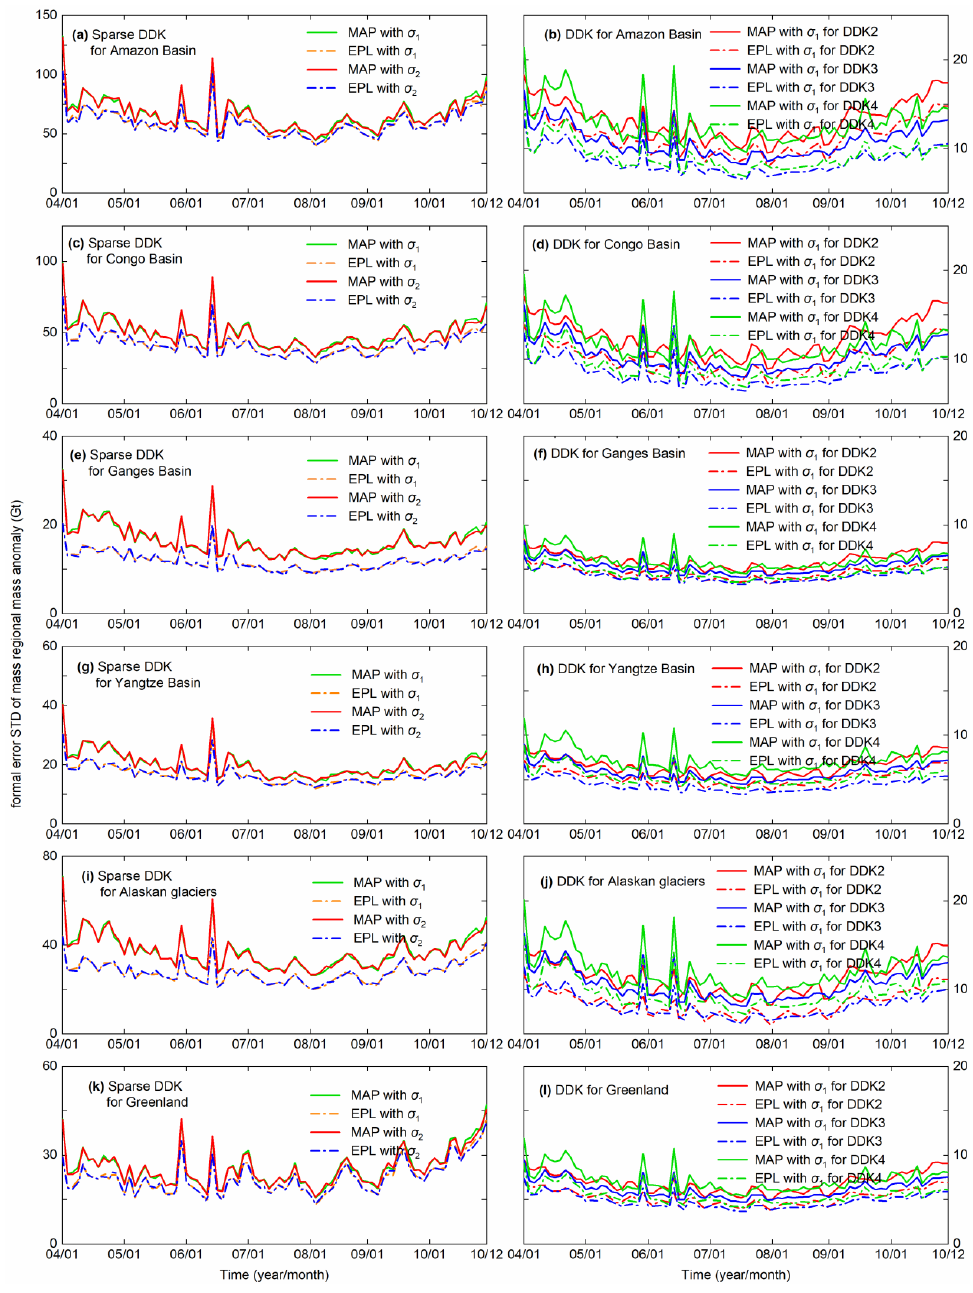
Figure 6. Formal error StD of regional mass anomaly versus time. Left panel: sparse DDK; right panel: DDK2, DDK3 and DDK4. From top to bottom are results for Amazon Basin, Congo Basin, Ganges Basin, Yangtze Basin, Alaskan glaciers, and Greenland. Note that the error covariance matrices Q DDK in DDK1, DDK2 and DDK3 are recovered from block-diagonal filtering matrix F DDK and signal covariance matrix S DDK .